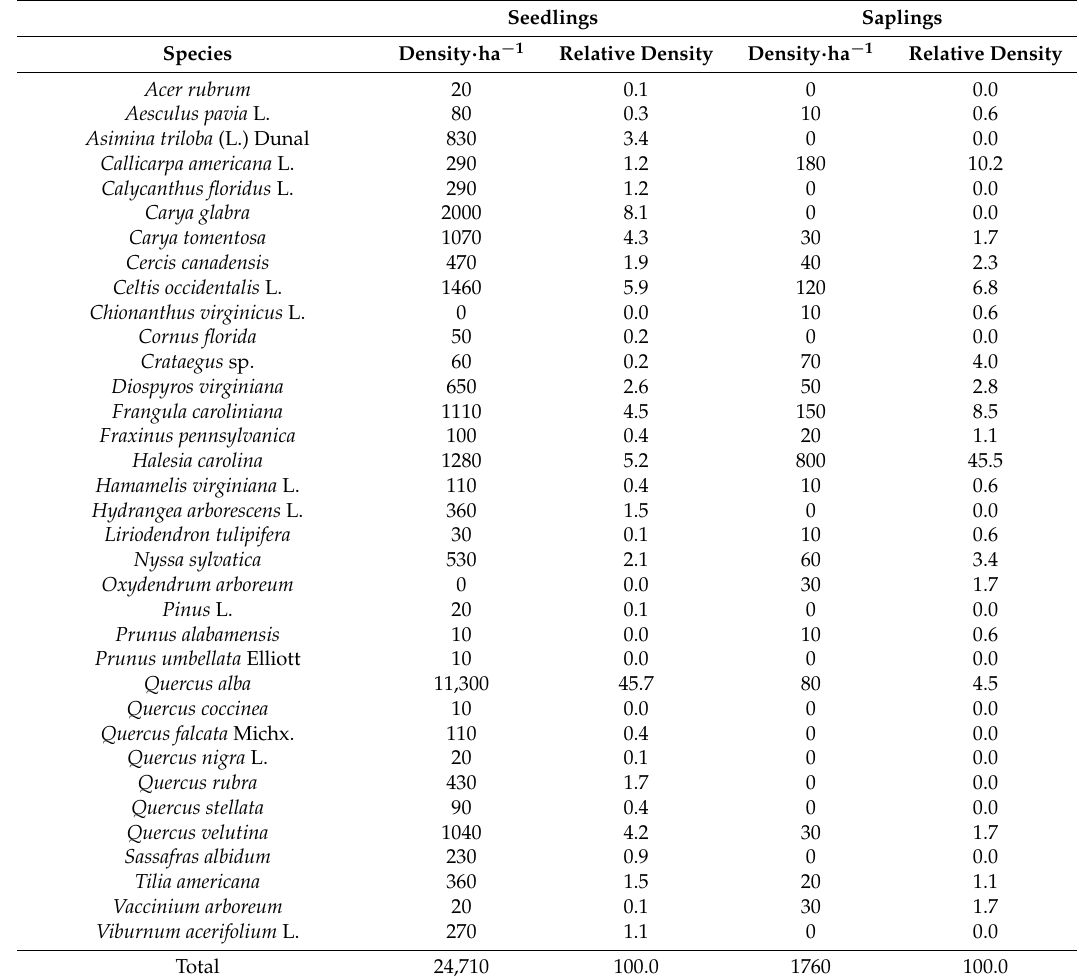
Table 2. Density (stems · ha − 1 ) and relative density of seedlings (live woody stems < 1 m height) and saplings (live woody stems ≥ 1.0 m height and <5 cm dbh) documented in a multi-cohort forest on the Oakmulgee Ranger District of the Talladega National Forest, Alabama. Listed